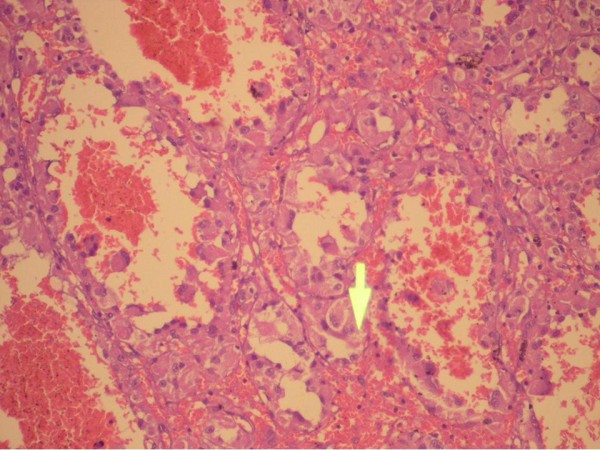
Histologic view.